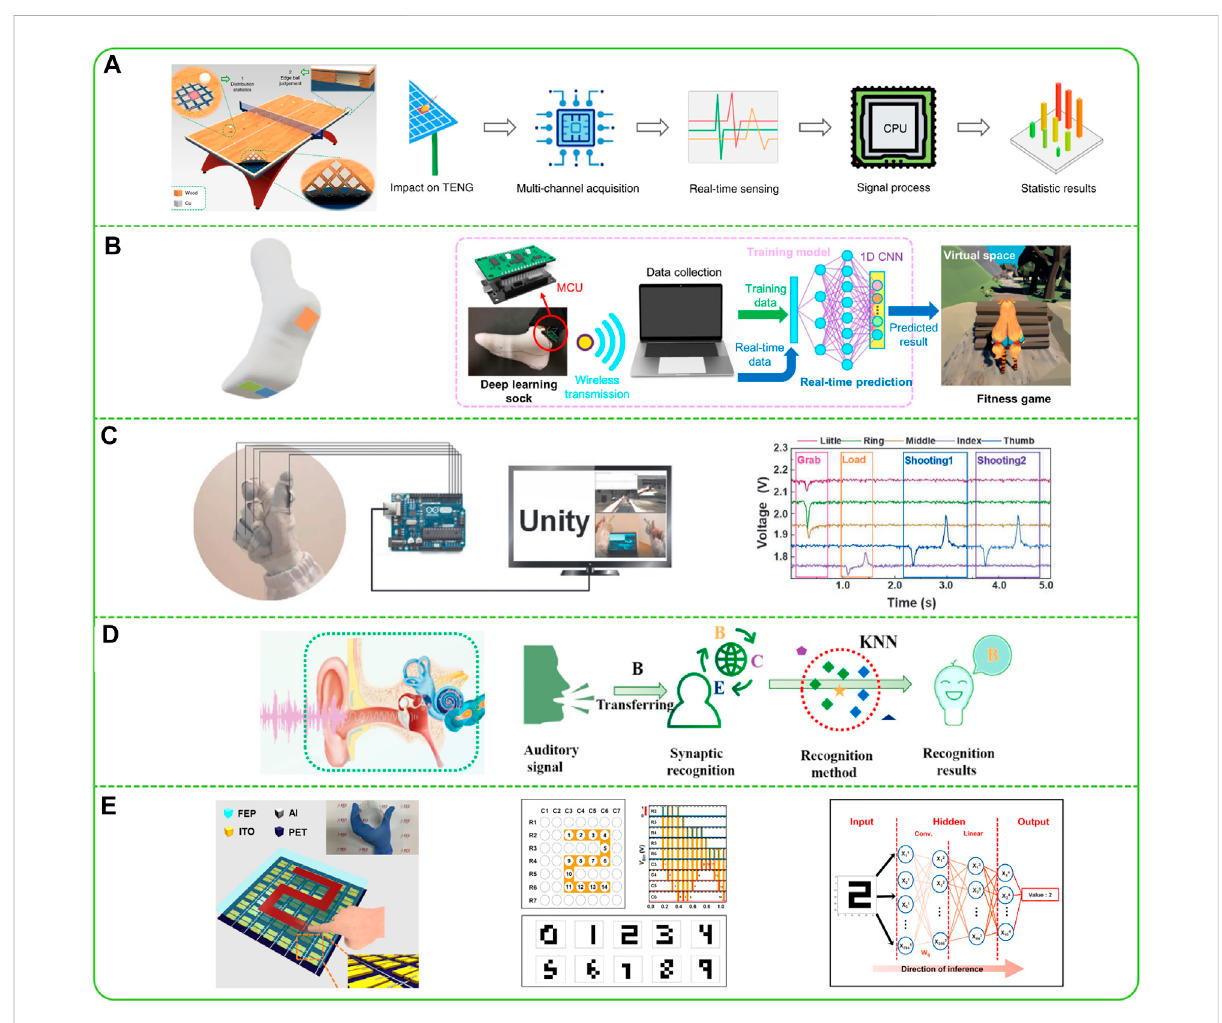
FIGURE 6 TENG-based self-powered sensors toward AI. (A) Fabrication and schematic of the fl exible wood-based TENG and smart ping-pong table and the schematic diagram of the W-TENG based self-powered falling point distribution statistical system (Luo et al., 2019). (B) Schematic of the triple- sensor socks and the process fl ow from sensory information collection to the real-time prediction in VR fi tness game (Zhang et al., 2020). (C) Schematicdiagramofthecontrolsystemandsignalpatternsofgrabbing,loadinggun,andshooting(Wenetal.,2020). (D) Schematicillustration of the human ear and the acoustic signal recognition process by the arti fi cial auditory pathway (Liu et al., 2020). (E) Schematic illustration of the proposedtouchpad,varioushand-writtennumberpatternswithbinarizeddata,andtheinterferenceprocessofhand-writtennumberpatternswitha pre-trained neural network (Yun et al.,